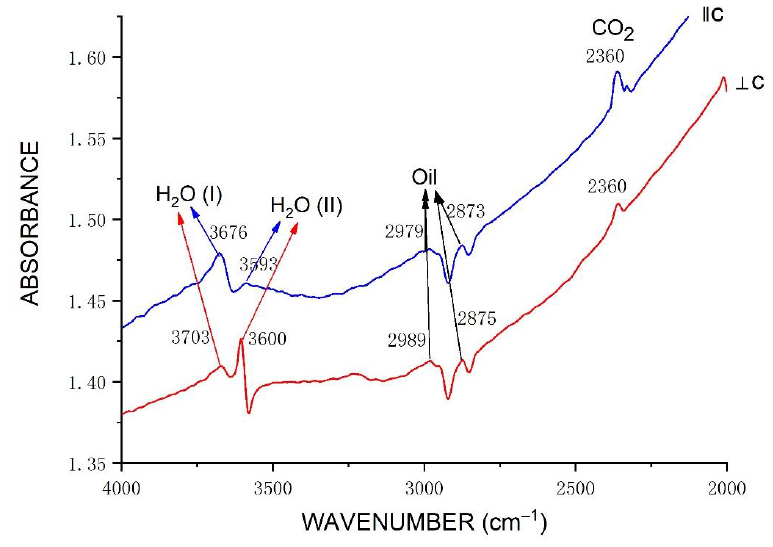
Figure 12. The representative FTIR spectrum of the two directions in the range of 4000–2000 cm − 1 . The significant peak at 2360 cm − 1 corresponds to CO 2 , which was present in all the samples. The infrared spectroscopy in the 3100–2800 cm − 1 range shows 2–3 absorption peaks associated with fillers used for clarity enhancement. None of the green fillers were seen in any samples, but some of the stones containing a near-colorless filler showed infrared spectra (Figure 12) typical of cedarwood oil, as indicated by absorptions at 2873, 2875, 2979, and 2989 cm − 1 [40]. Figure 13 shows typical FTIR spectra (o-ray) in the range of 7200–4000 cm − 1 . The peaks at 7078 and 5273 cm − 1 of type II H 2 O are sharp and strong, while the peak at 7136, 5587, and 6821 cm − 1 of type I are weak [36,41].